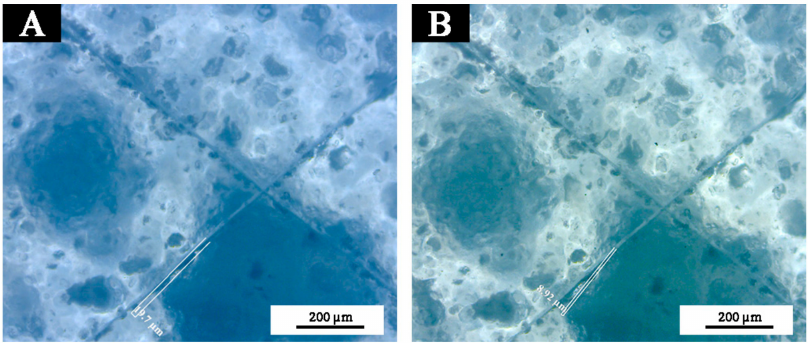
Figure 14. OM of waterborne coating with 10.0% concentration of microcapsules (core–wall ratio is 0.58:1). ( A ) Before healing; ( B ) after healing.